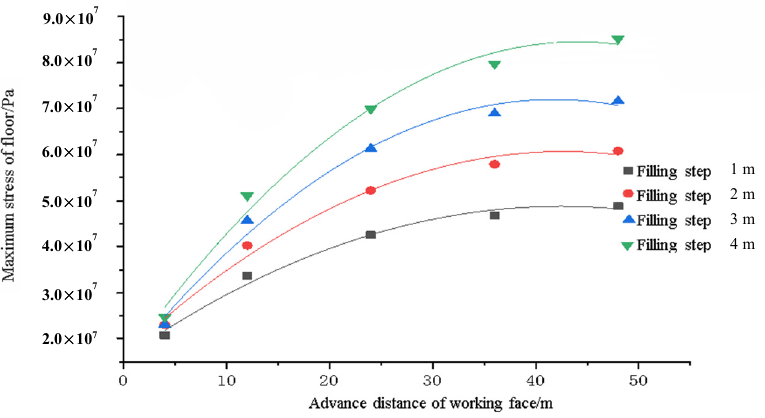
Figure 8. The relationship between the maximum stress of paste-filling face floor and the advancing distance of working face under different filling steps.